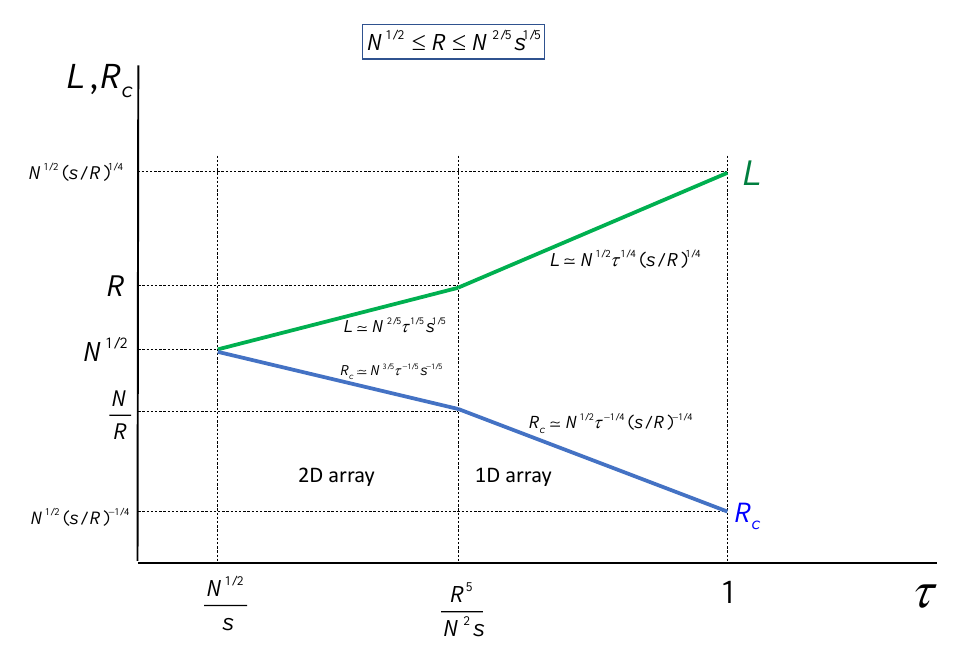
Figure 14. Dependence of the cluster size, L , and cluster core radius, R c on solvent strength τ ∼ = ( χ − 1/2 ) at pore radius N 1/2 ≤ R ≤ N 2/5 s 1/2 , and grafting density is σ = 1/ s ≤ N − 1/2